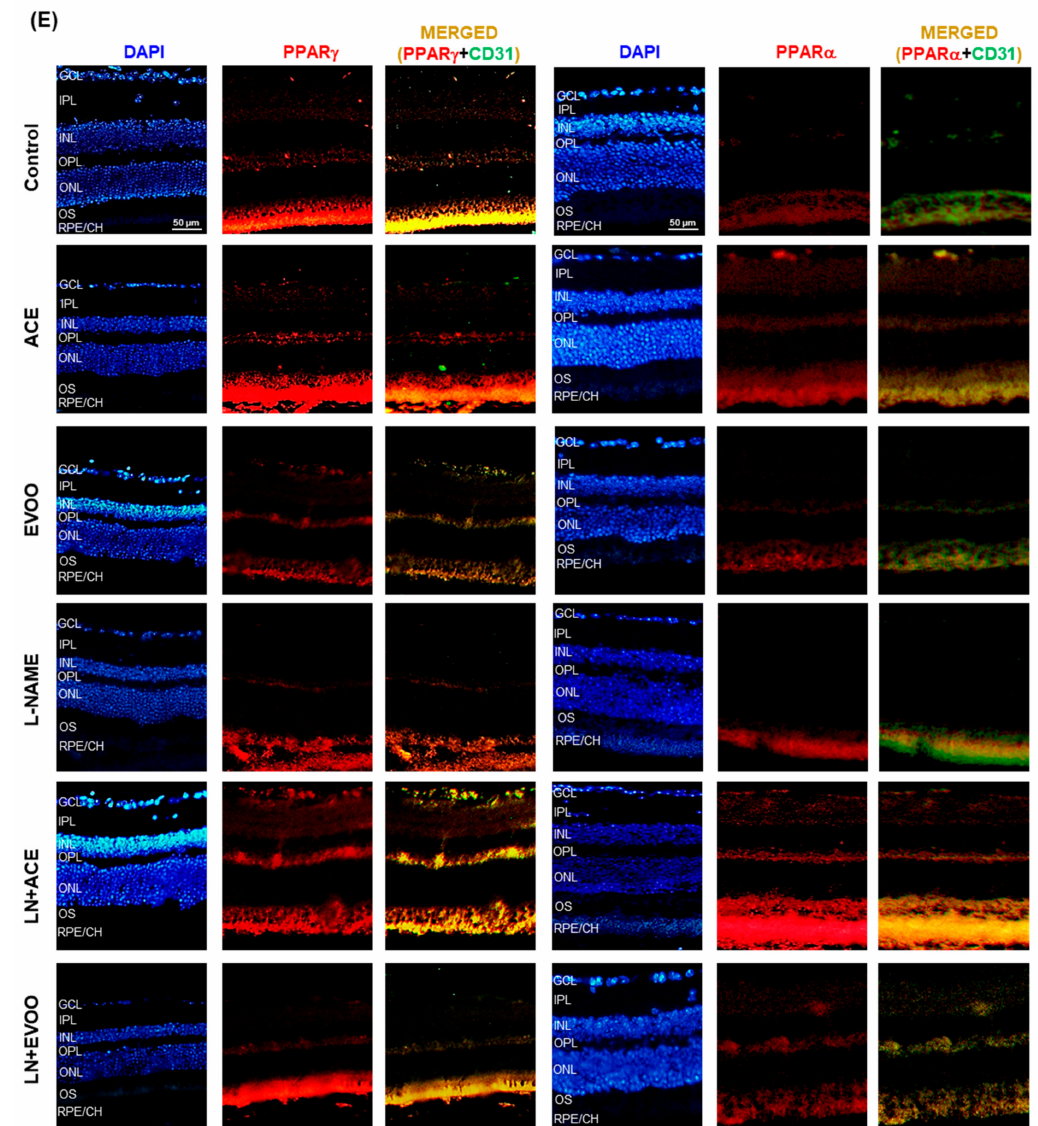
Figure 3. Protein expression of ( A ) PPAR γ and ( B ) PPAR α in retina homogenates. Quantitative analyses of fluorescence signal of ( C ) PPAR γ and ( D ) PPAR α in the retinal layers and choroid, and ( E ) representative fluorescence signal of PPAR γ (left) and PPAR α (right), as indicated. Panels show PPAR expression (red) and double staining with CD-31 (green) in the different retinal layers, with the merge visible in yellow color. Nuclei staining with DAPI (blue color) was used to identify the different retinal layers in each experimental group. Magnification: 10 × . Values are expressed as mean ± SEM of five animals per group: a p < 0.05 vs. Control; b p < 0.05 vs. L-NAME; c p < 0.05 vs. EVOO; d p < 0.05 vs. LN + EVOO; e p < 0.05 vs. ACE. GCL: ganglion cell layer; IPL, inner plexiform layer; INL, inner nuclear layer; OPL, outer plexiform layer; ONL, outer nuclear layer; OS, outer segments; RPE/CH, retinal pigmentary